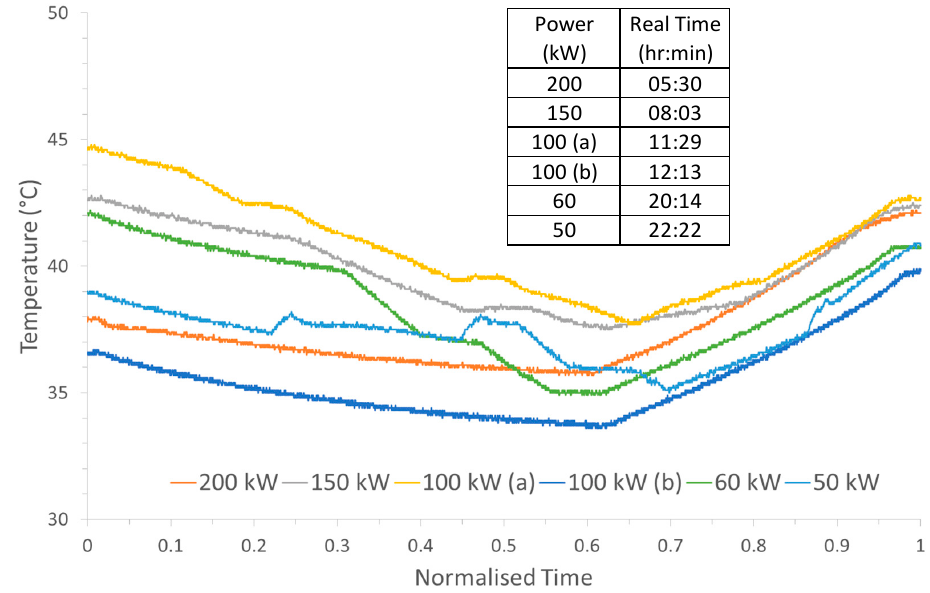
Figure 9. Temperature profiles for each charge/discharge cycle at different power levels under a normalised time for direct comparison. Actual times shown in insert.